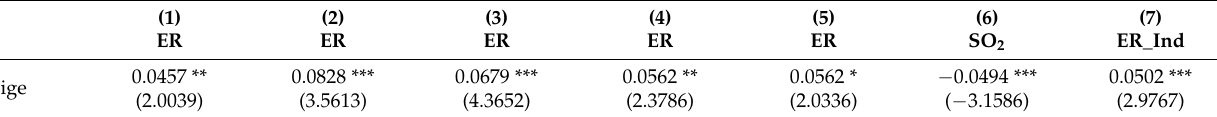
Table 6. Robustness